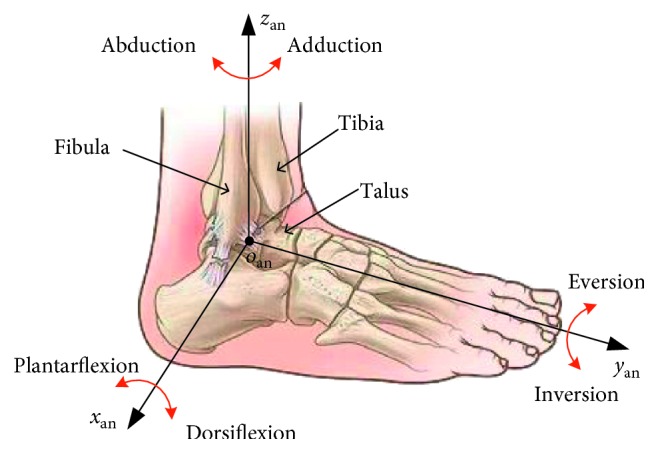
Skeletal structure of the ankle joint.